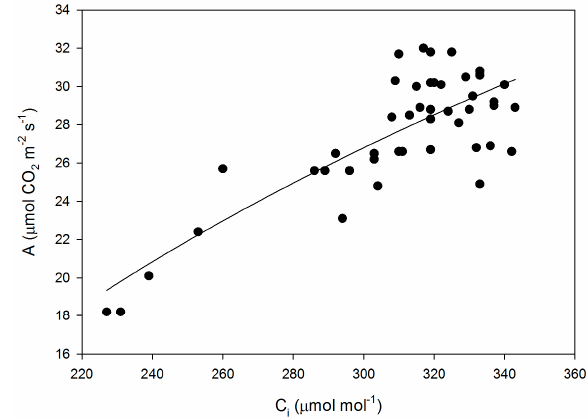
Figure 5. The ratio of V Cmax based on C i to that based on C c as a function of mesophyll resistance, the reciprocal of g m , for all measurements made on fifteen cultivars of soybean. The linear regression: